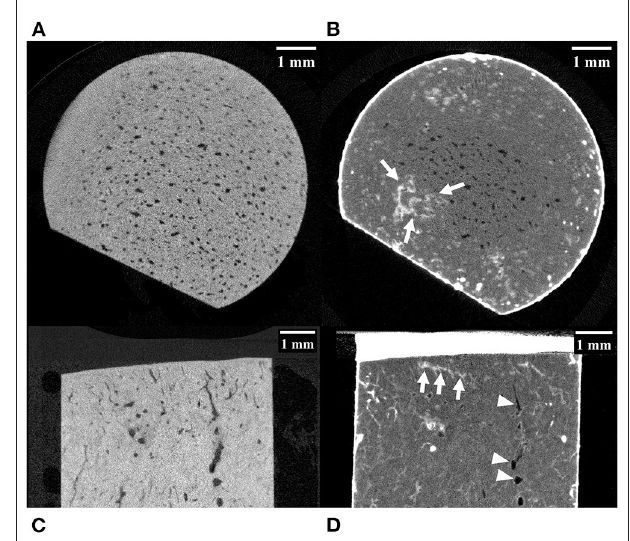
FIGURE 2 | MicroCT images of a palmar MCIII cartilage-bone specimen from a Thoroughbred racehorse with microfractures before (A,C) and after (B,D) staining the bone with lead-uranyl acetate. Image (A) and (B) are short axis images taken approximately 1mm below the mineralized to non-mineralized cartilage interface. Images (C) and (D) are long axis images of the superficial half of the specimen. Image (A) was taken at an approximately equivalent slice as image (B) ; likewise, with images (C) and (D) . The staining in images (B) and (D) confirms uptake in this specimen with known microdamage (arrows). Resorptive lesions are present (arrowheads).